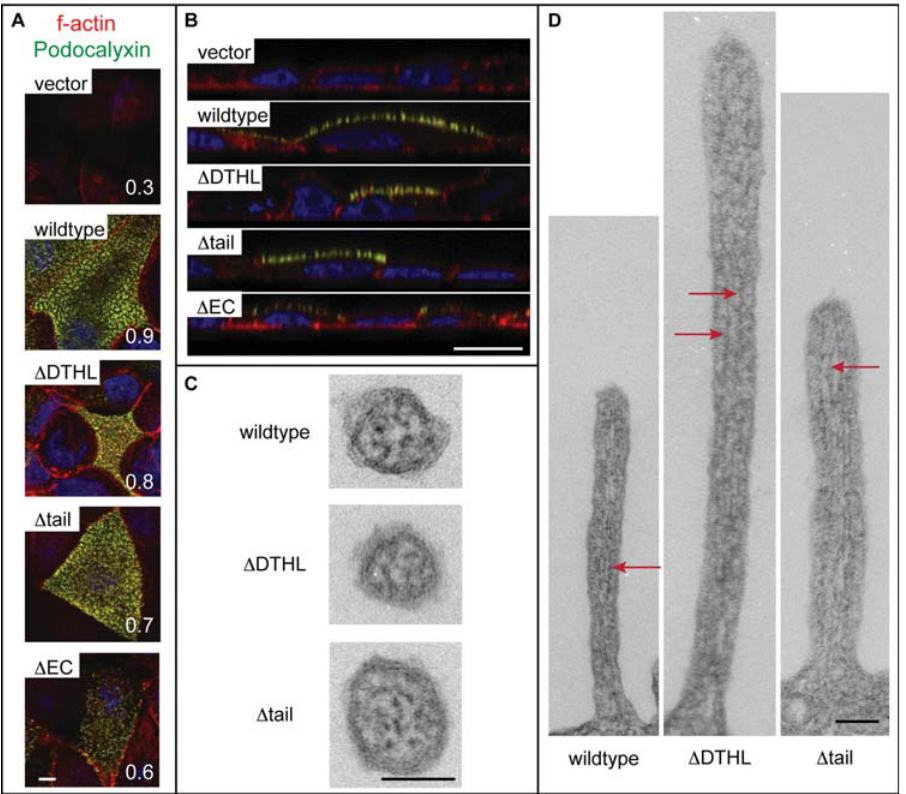
Figure 10. Podocalyxin colocalizes with f-actin at the apical surface of cells, even in the absence of most of Podocalyxin’s cytoplasmic tail. (A, B) Podocalyxin-transfected MCF-7 cells with f-actin (red), ectopic Podocalyxin (green), and DAPI (blue) labeling. Scale bars: 5 m m. (A) Projections of merged apical confocal images; white numbers represent Pearson’s colocalization coefficient. (B) Vertical slices of confocal stacks. (C, D) High magnification TEM images demonstrate the presence of actin filaments (red arrows) running the length of individual microvilli. Although microvilli of different lengths are shown in this figure, there was no consistent difference in microvilli lengths between samples. Scale bars: 0.1 m m. (C) Cross- sections; (D)